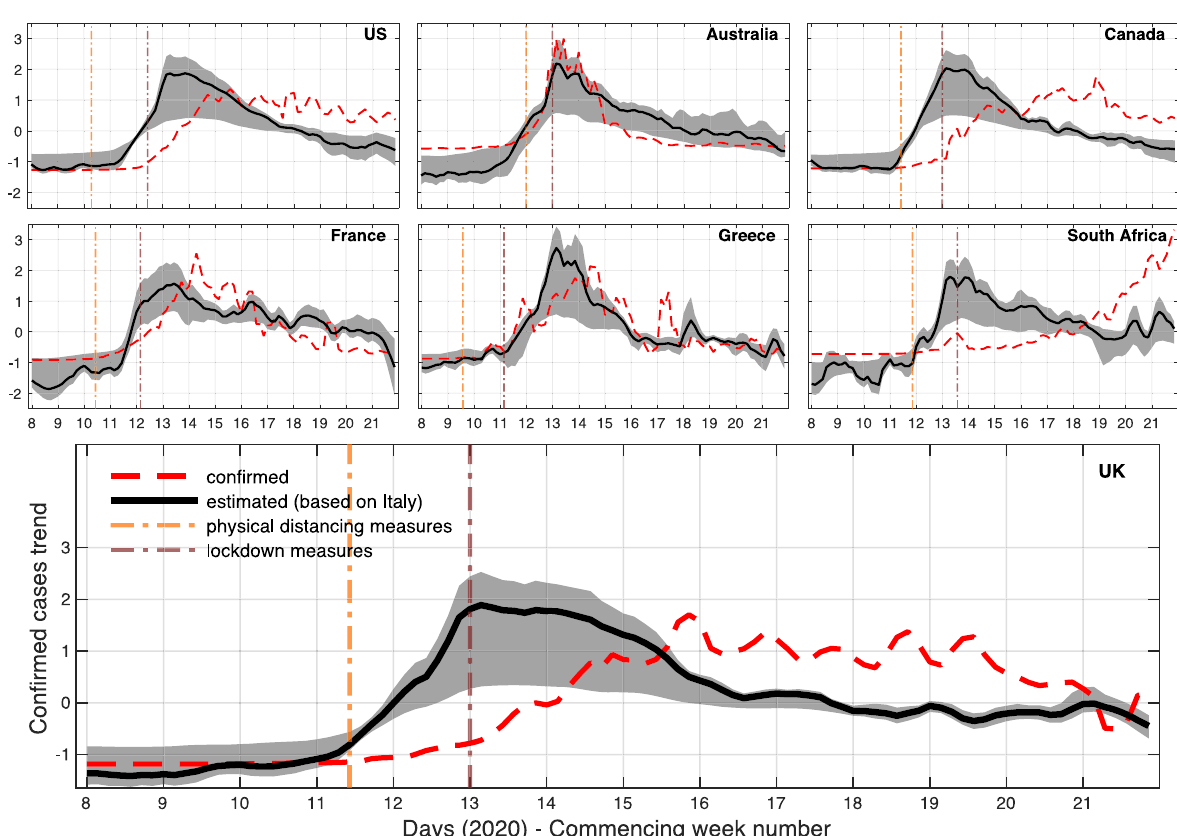
Fig. 3 Transfer learning models based on online search data for 7 countries using Italy as the source country. The fi gures show an estimated trend for con fi rmed COVID-19 cases compared to the reported one. The trend is derived by standardising the transferred estimates (raw values are re fl ective of the demographics and clinical reporting approach of the source country). The solid line represents the mean estimate from an ensemble of models. The shaded area shows 95% con fi dence intervals based on all model estimates. Application dates for physical distancing or lockdown measures are indicated with dash-dotted vertical lines; for countries that deployed different regional approaches, the fi rst application of such measures is depicted. Time series are smoothed using a 3-point moving average, centred around each day. We use this minimum amount of smoothing to remove some of the noise for visualisation purposes and maintain our ability to compare the transferred models to the corresponding clinical